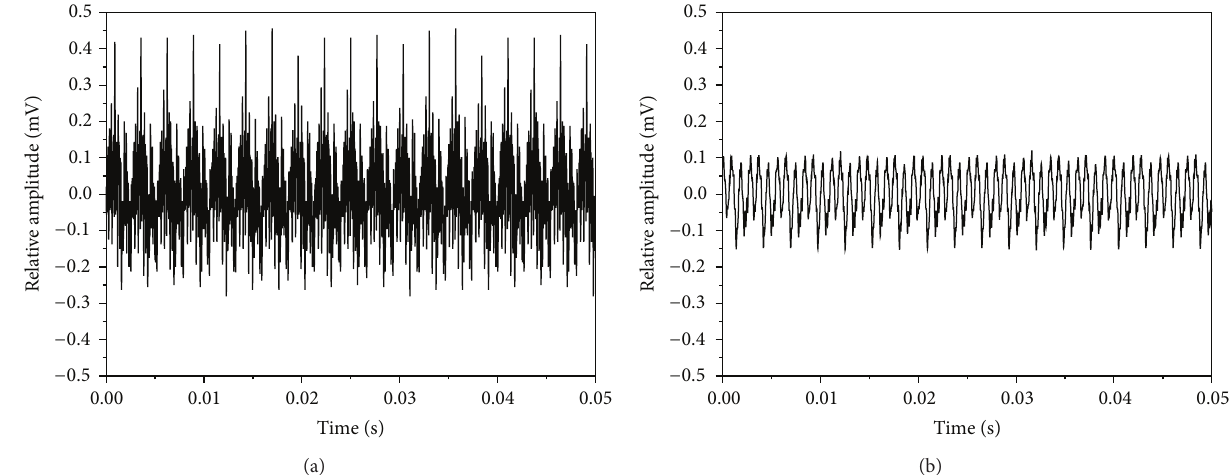
Figure 7: The waveform of the TX-VSR (a) resonant: 375 Hz and (b) subresonant: 362